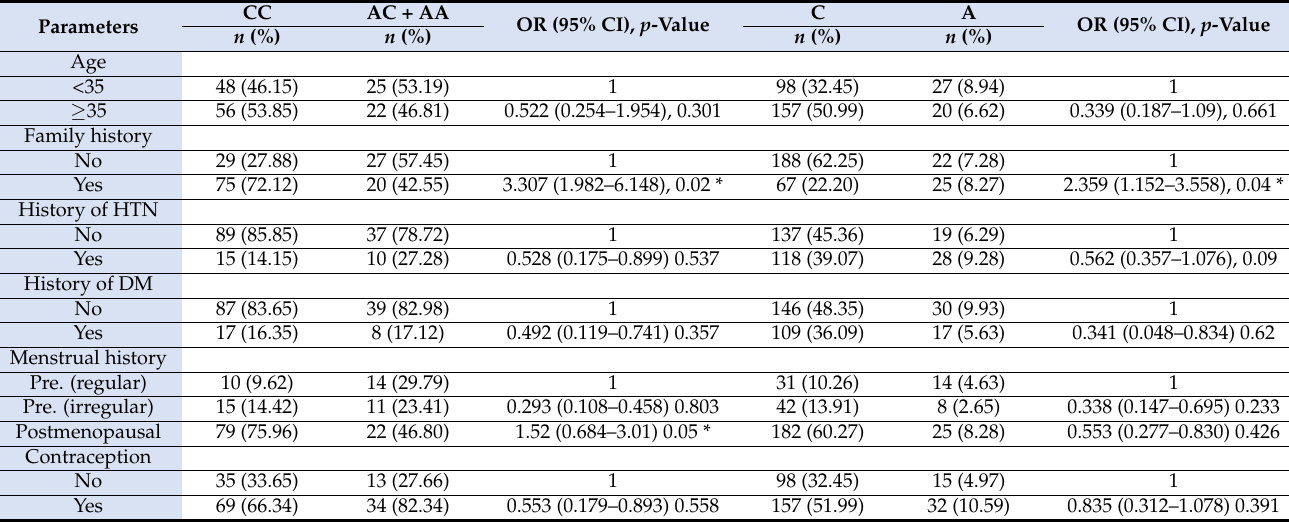
Table 3. Genotype and allele frequencies of rs1859168 according to the clinical characteristics of the patients with